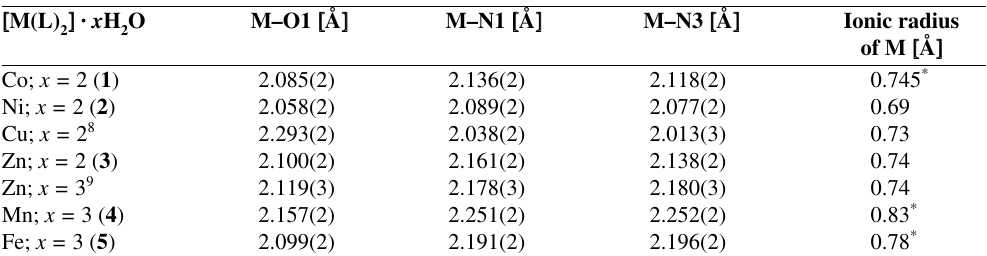
Table 2. Bonding distances within the first coordination sphere of central metal ions in 1 – 5 and their hydrated copper and zinc analogues. 8,9